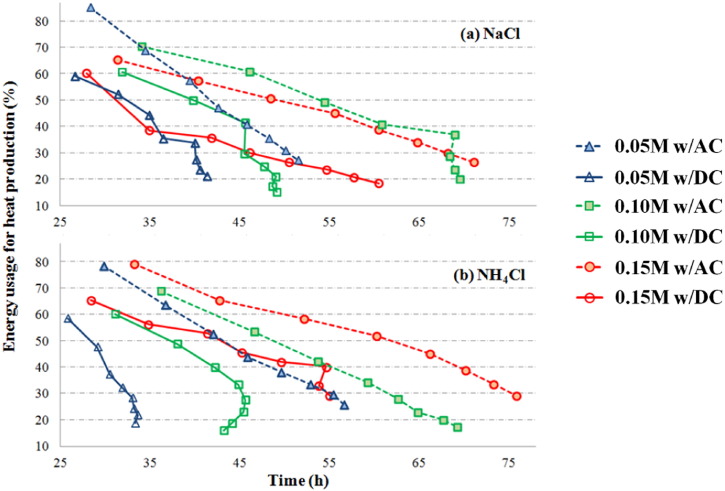
Percentage of energy usage for heat production at different experimental conditions.